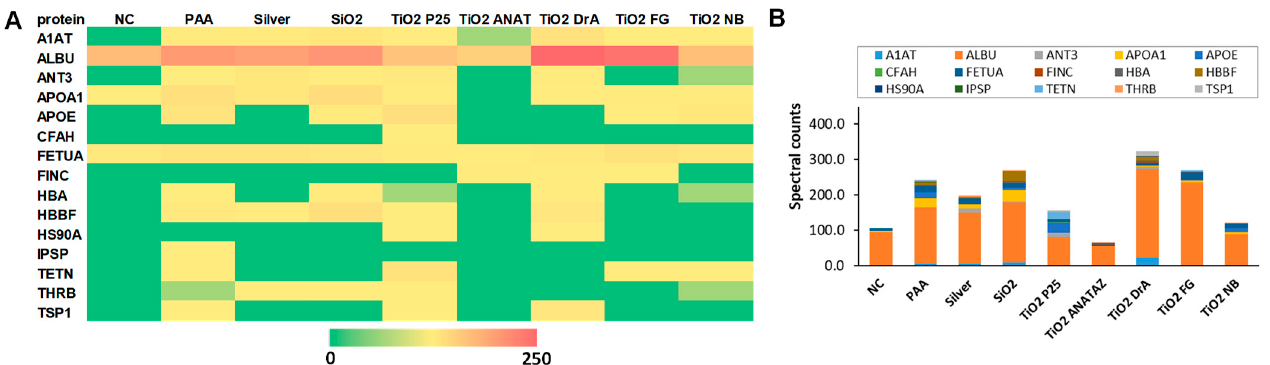
Figure 3. Composition of protein corona after 1 h of NP incubation in RPMI-1640 media with 10% ( m / v ) FBS. Proteins were separated from NPs, analyzed using SDS-PAGE, and identified via MS. ( A ) Heatmap of protein abundance (spectral counts obtained from MS) and ( B ) protein abundance. the average values of three independent repeats are presented (see also Figures S4 and S5, and Table S2). Full names of the proteins are provided in Supplementary Information (Table S1).